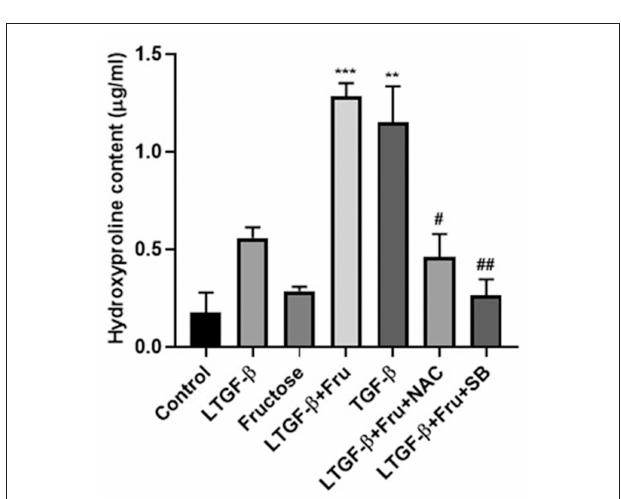
FIGURE 8 | Effect of fructose on the content of hydroxyproline. A549 cells were treated under the indicated conditions, and then the cell supernatant was collected, and the hydroxyproline kit determined the hydroxyproline content. Data are set as the Mean ± SEM ( n = 3). Comparisons between groups were achieved using a one-way ANOVA followed by Tukey’s test. ** p < 0.001, *** p < 0.001 vs. control group; # p < 0.05, ## p < 0.01, compared with the LTGF- β 1 + Fru group. Control, 0mM fructose; LTGF- β 1 + Fru, latent TGF- β 1 + 10mM fructose; LTGF- β 1 + Fru + NAC, latent TGF- β 1 + 10mM fructose + N-Acetyl-l-cysteine; LTGF- β 1 + Fru + SB, latent TGF- β 1 + 10mM fructose +